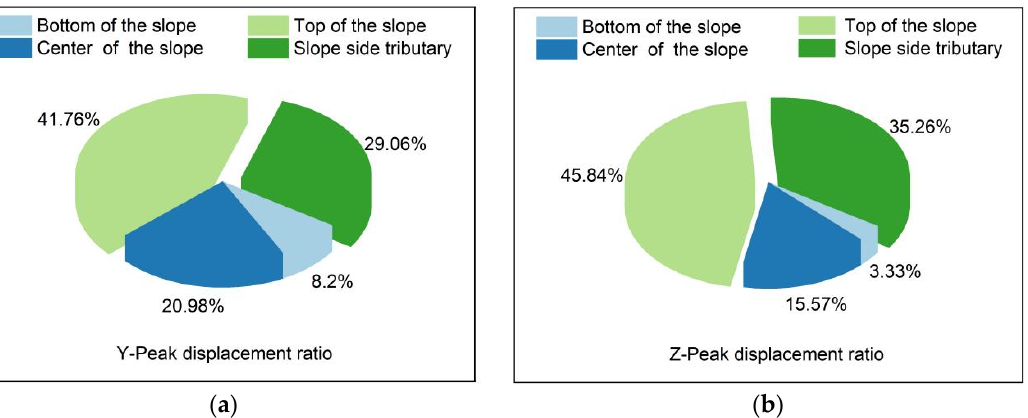
Figure 16. Percentage of the peak displacement of the monitoring points. ( a ) Proportion of peak displacement in the Y-direction. ( b ) Proportion of peak displacement in the Z-direction.